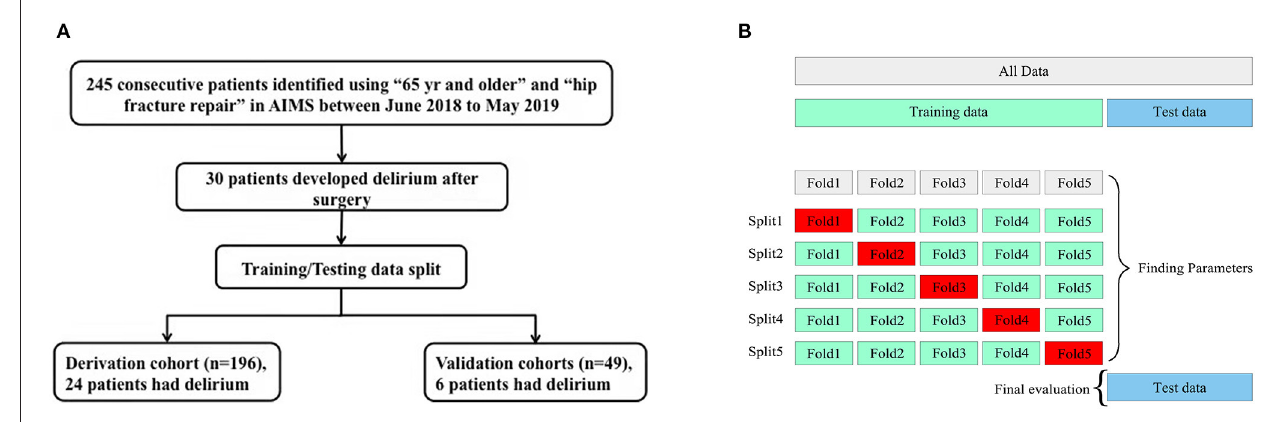
FIGURE 1 | Trial profile and diagram of machine learning model construction. (A) Trial profile. (B) Diagram of machine learning model construction. AIMS, Anesthesia Information Management System. The complete dataset was split into the training set and test set. The machine learning methods were trained on the training set and applied to the test set for validation and reaching accuracy of prediction. K-fold cross-validation method was deployed (k = 5) to accomplish internal validation and performance evaluation, which divides the training dataset into k-folds, with 39 patients each in fold 1 to fold 4 and 40 patients in fold 5, respectively.